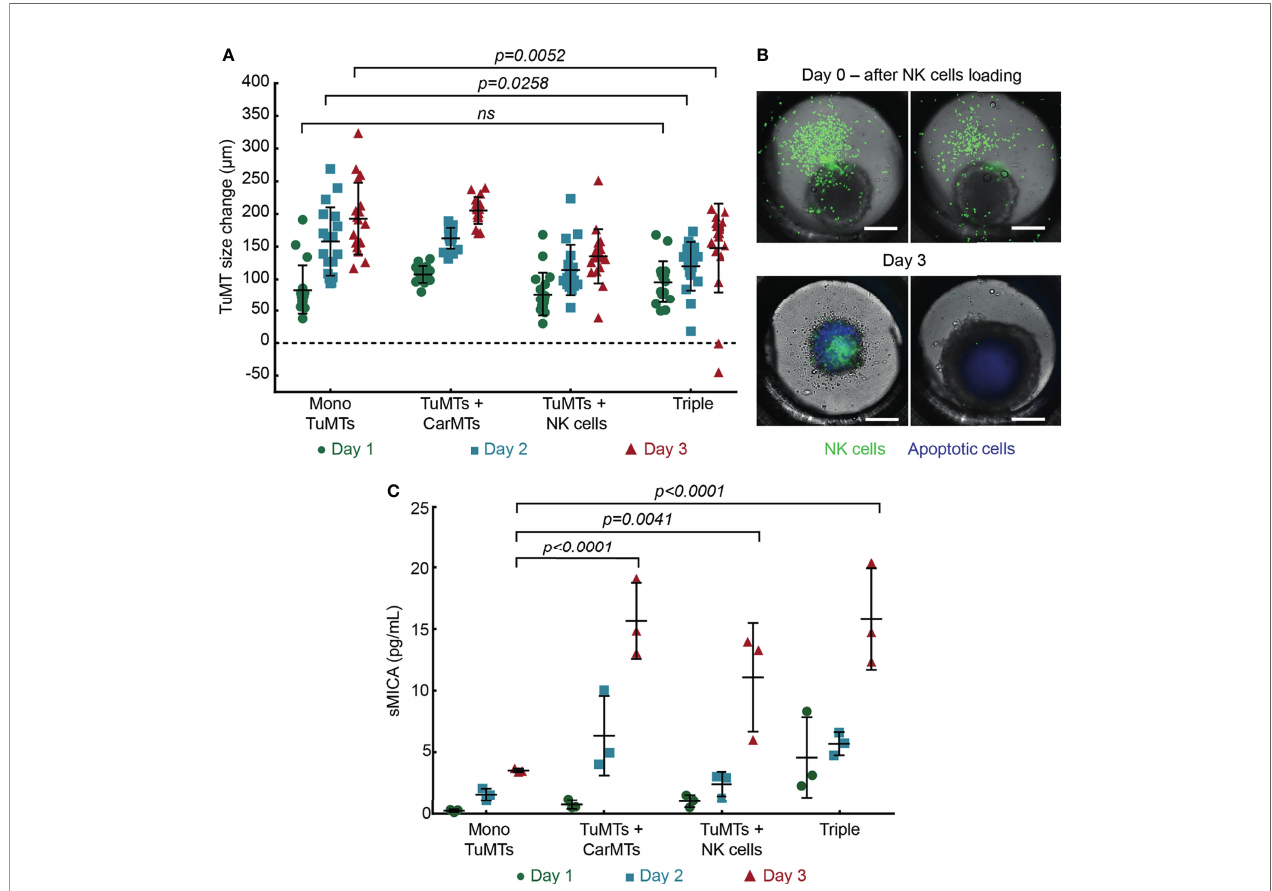
FIGURE 3 | (A) TuMT size changes monitored by bright- fi eld imaging. Diameters of individual TuMTs measured at Day 1 (D1), Day 2 (D2), and Day 3 (D3) were normalized to their own diameter at day 0 (n = 18 MTs) (Mono: mono-culture, Triple: triple culture). Detailed statistical comparisons between conditions are shown in Figure S4A (ns: not signi fi cant). (B) Representative fl uorescence images re fl ecting heterogeneous size changes of TuMTs in triple cultures. NK cells were labeled with Green fl uorescence cell proliferation staining reagent, while apoptotic cells were labeled with Blue 405 Caspase-3 Dye. Scale bars: 200 m m. (C) Quantitation of sMICA released into the supernatant of different cell cultures during a 3-day experiment (n = 3). Detailed statistical comparisons between conditions are shown in Figure S4B